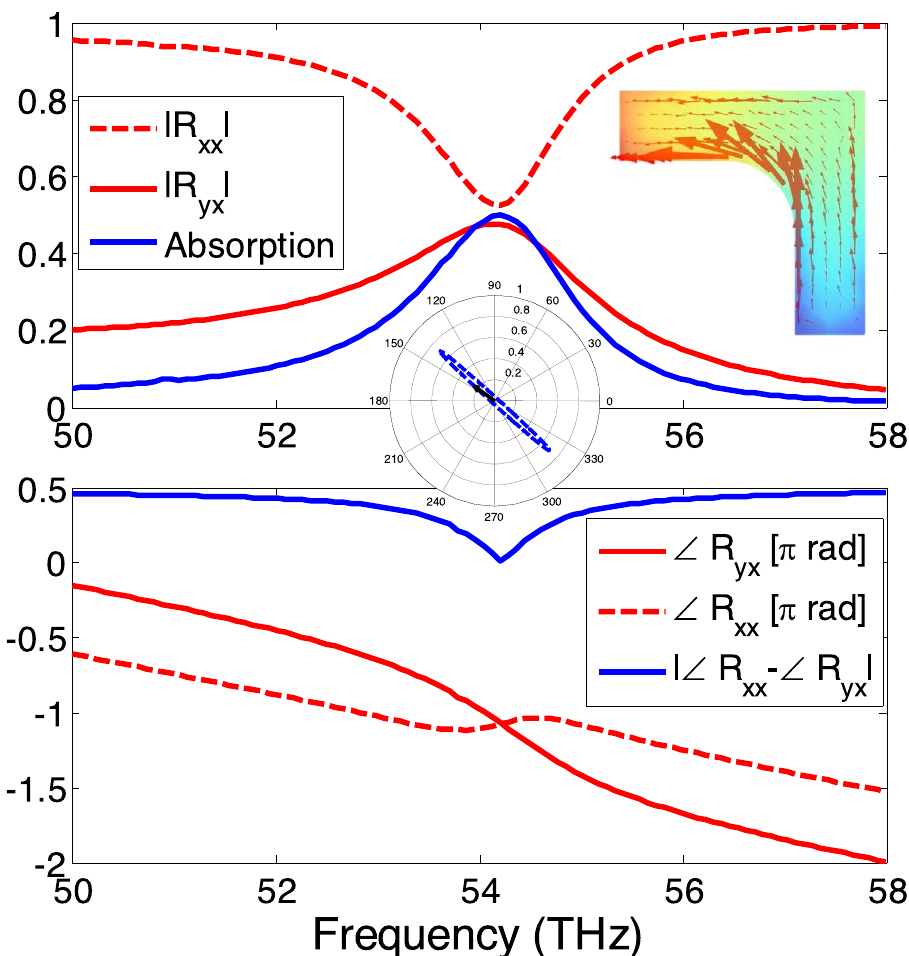
Figure 3. Magnitude and phase of the co-polarized ( R xx ) and cross-polarized ( R yx ) reflection coefficients and the absorption coefficient for the single-L chiral metasurface shown in Fig. 2 when it is illuminated with a x-polarized normally incident electromagnetic wave. The absorption coefficient A is calculated from Eq. 3. The inset shows the magnitude and direction of the surface current density at resonant frequencies of 54.2 THz and the associated polarization ellipse for the reflected fields. The chiral current distribution is provided in instantaneous time varying form in supplementary materials.